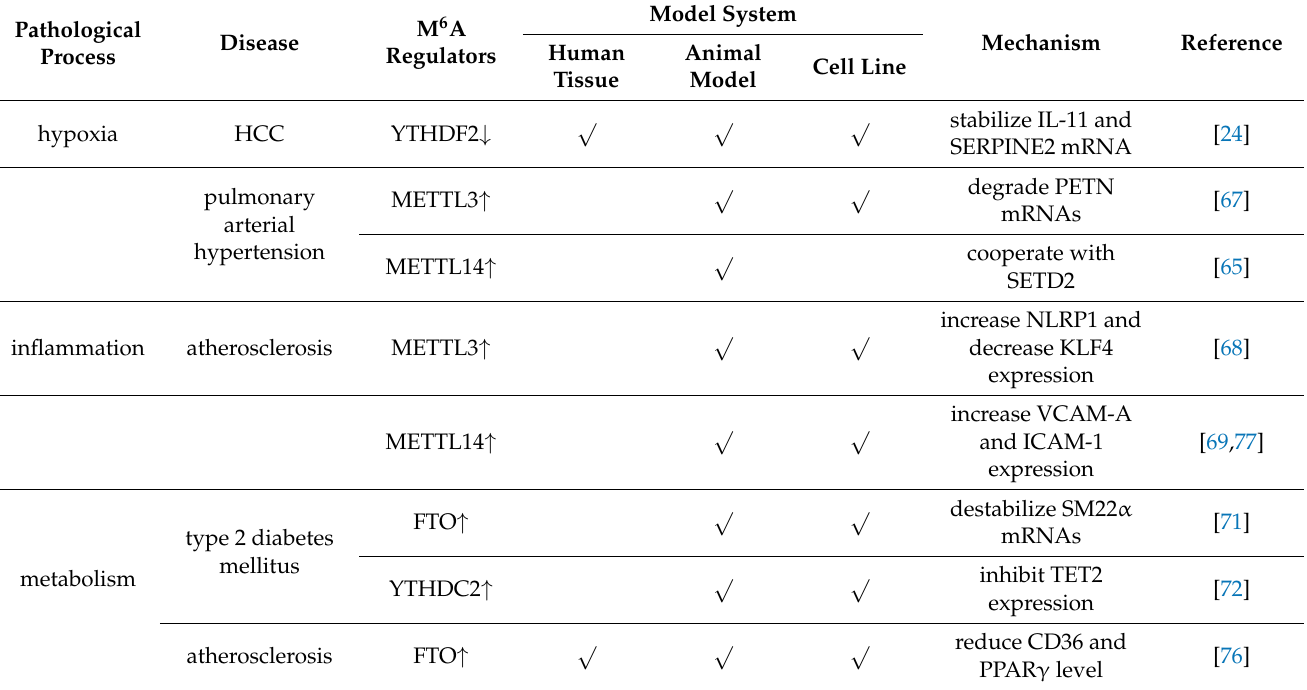
Table 3. Molecular mechanisms of m 6 A modification in microvascular